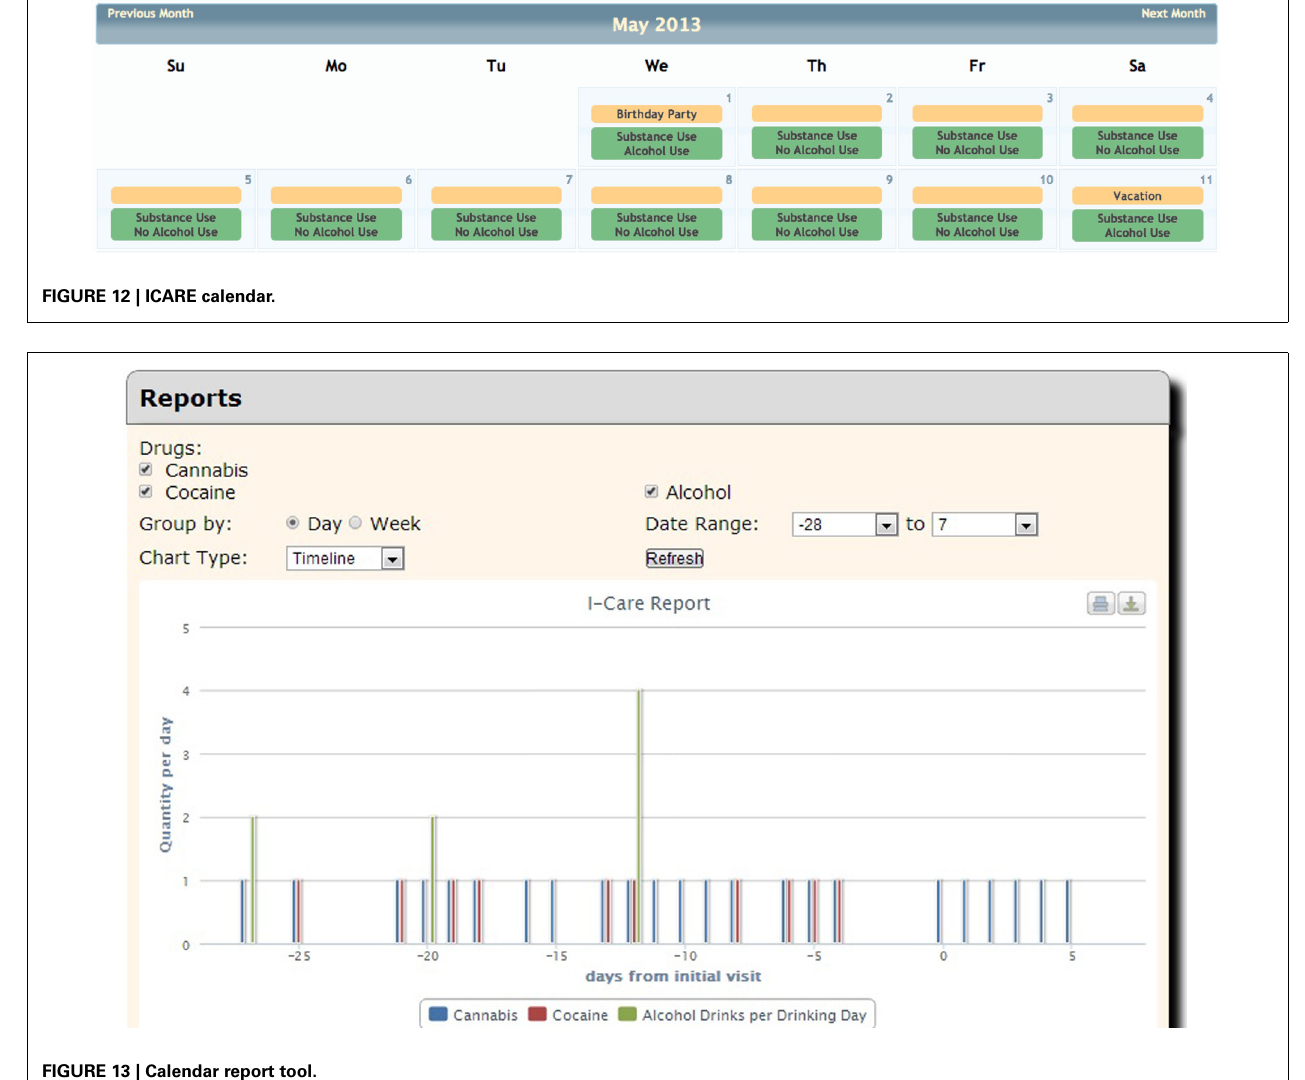
FIGURE 13 | Calendar report